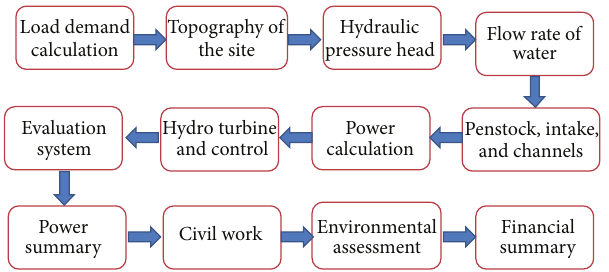
Figure 2: Planning and evaluation of a small hydropower plant